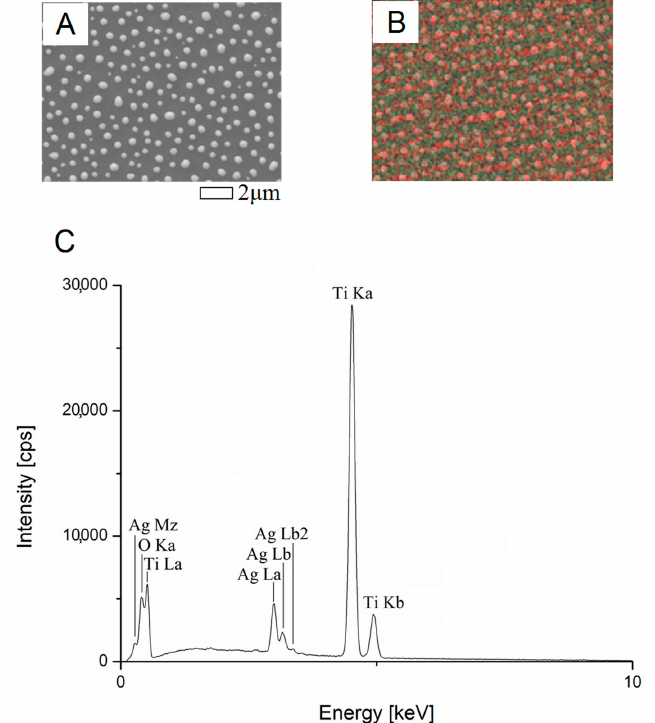
Figure 3. Scanning electron microscopy image ( A ) with the corresponding composition mapping image ( B ) and spectra ( C ). The typical characteristic lines of the elements are marked in the spectra.